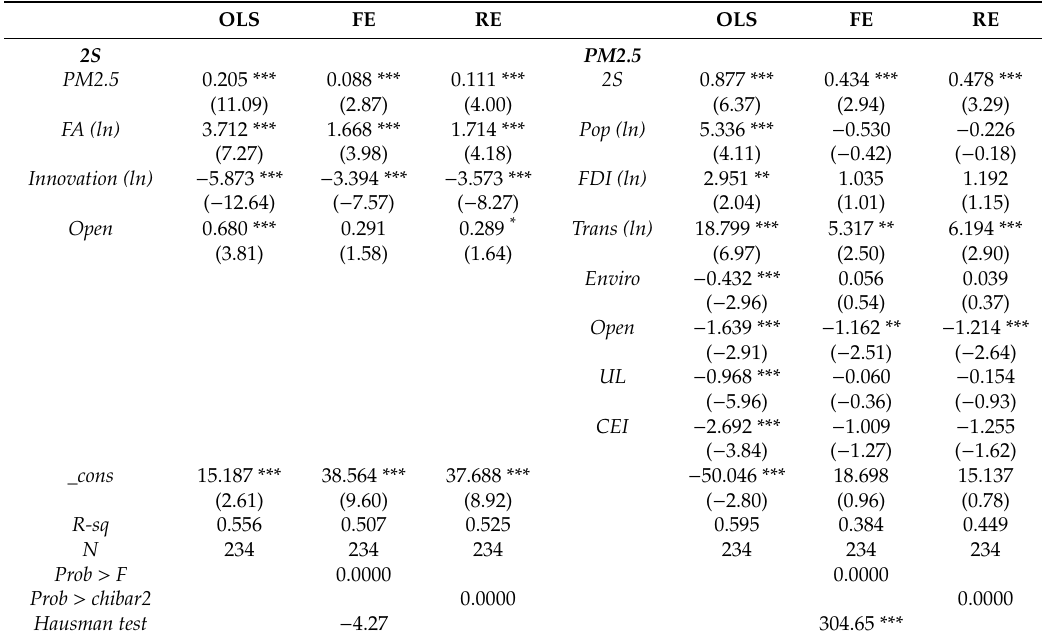
Table 2. Single equation estimation results of secondary industry and air pollution.